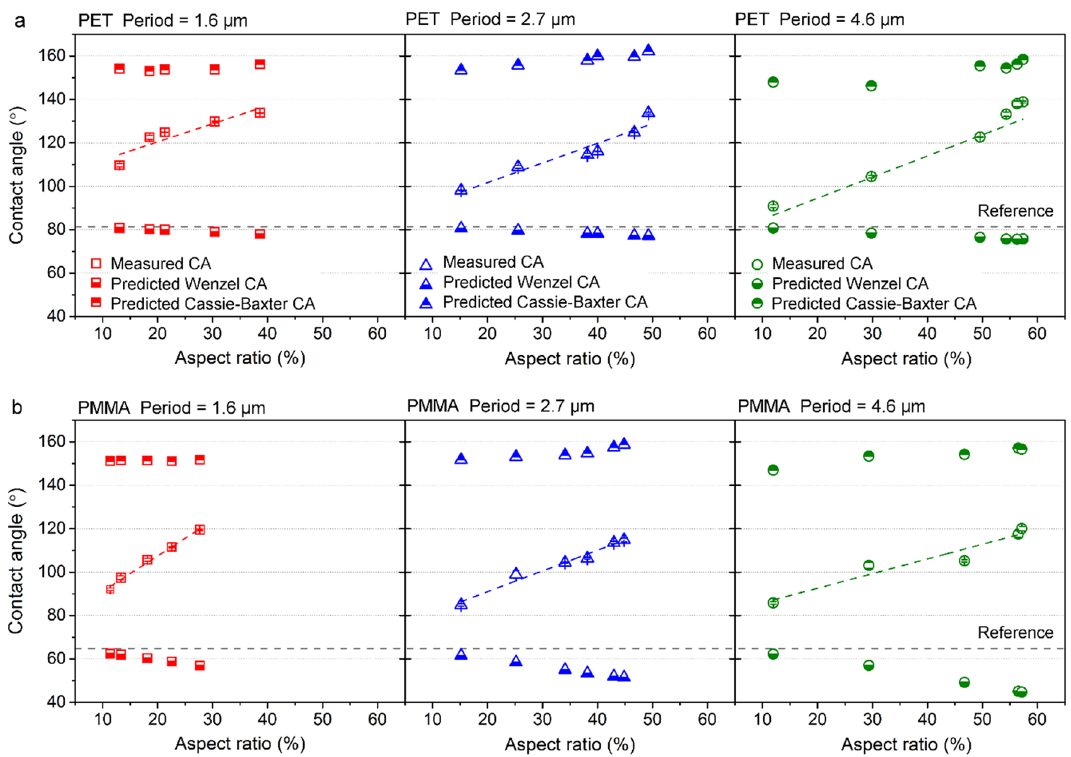
angle on the smooth original polymer